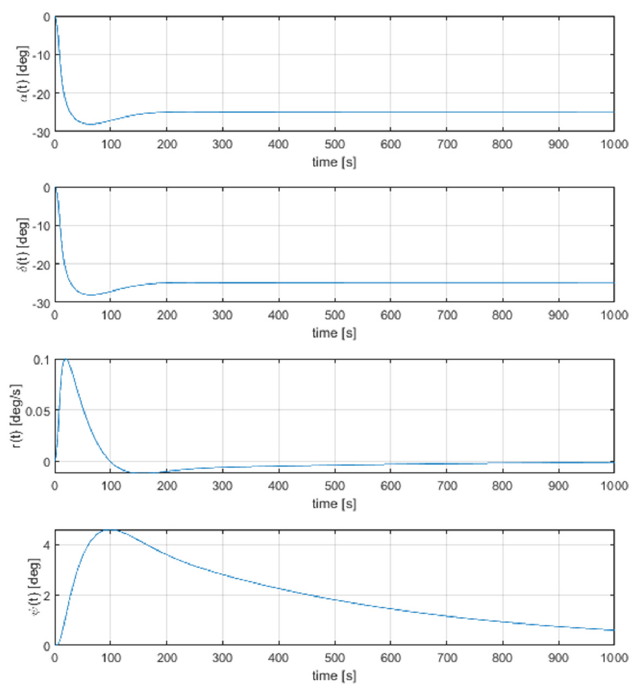
Figure 3. Reaction of heading angle on constant disturbance.